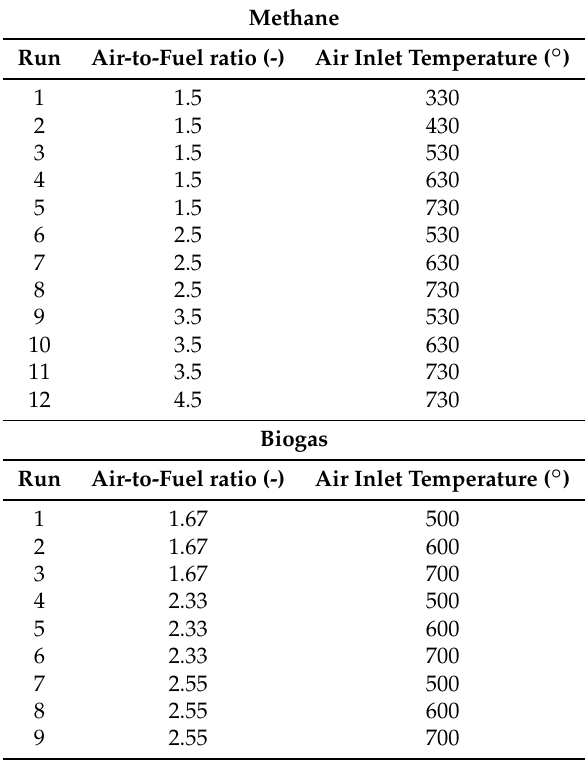
Table 2. Summary of the conditions for all the experimental runs, for both methane and biogas. Methane Run Air-to-Fuel ratio